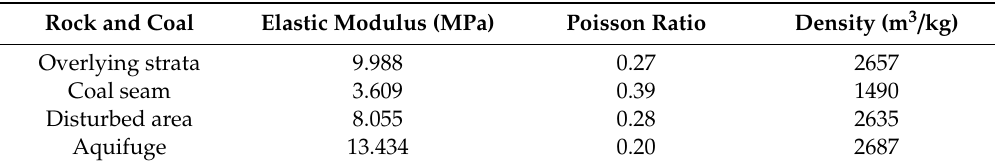
Table 3. The model parameters of rock and